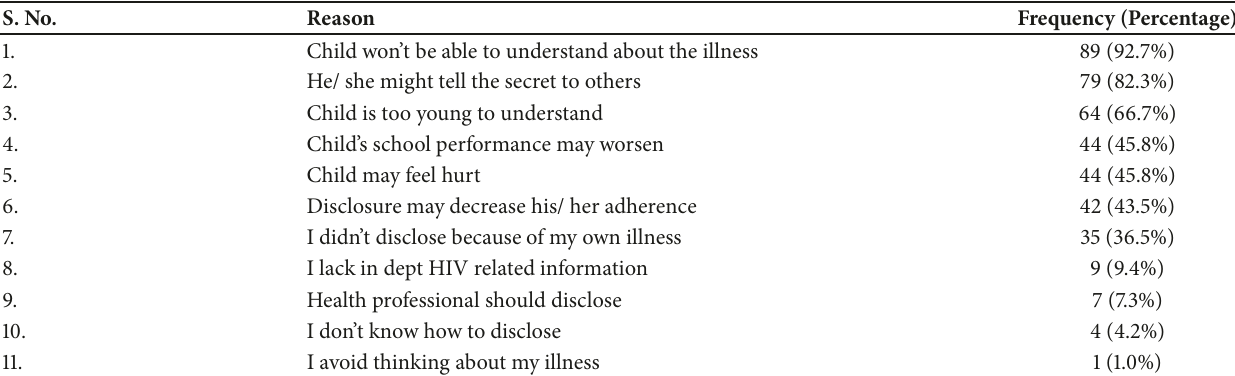
Table 4: Reasons behind nondisclosure of HIV status.